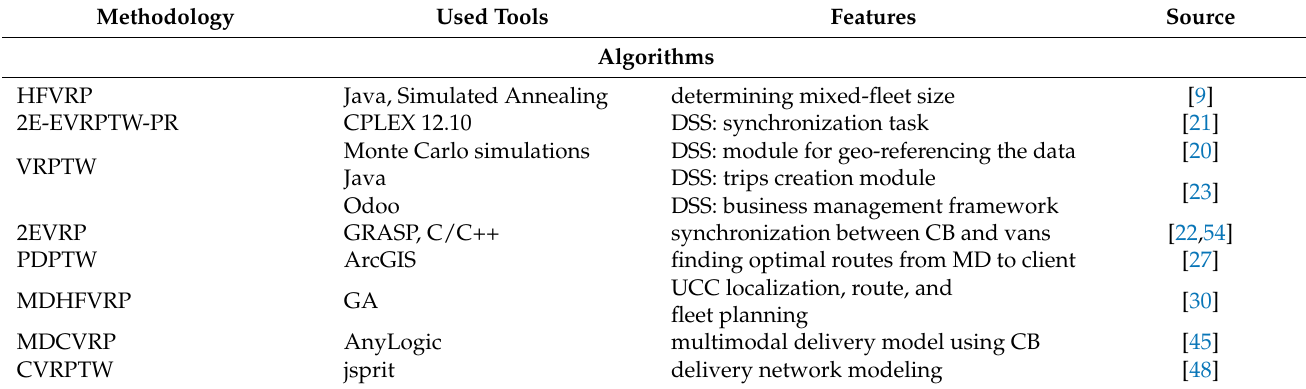
Table 2. Approaches to modeling systems of delivery by means of